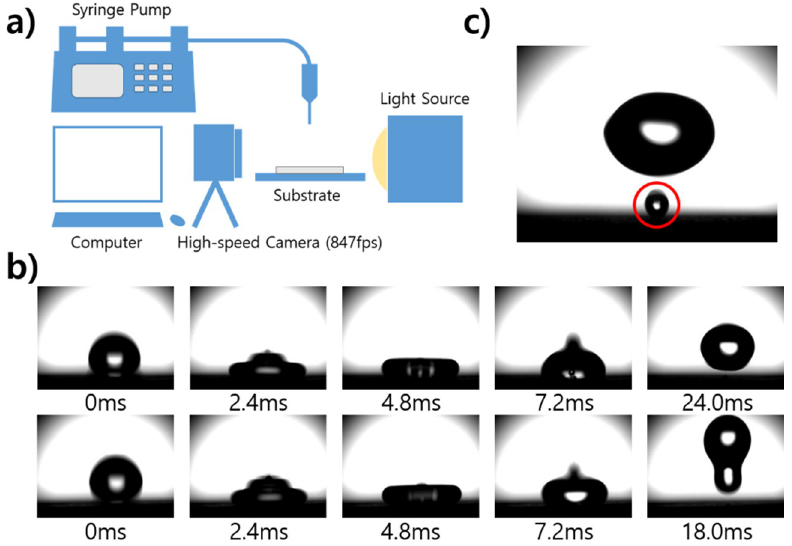
Fig 4. Observation and analysis of droplet collisions. (a) Composition of experimental equipment for droplet collision observation. The needle dropped droplets at a height of 20 mm from the surface and the droplet size is 2.8 ± 0.2 mm. The velocity of the droplet was 1.02 m/s. (b) Results of high speed cameras from contact with droplets to removal from surfaces. Compared with the specimen treated with the PE method, water droplets splashed faster on the specimen treated with RIE. (c) When water droplets bounced from the specimen treated with the PE method, small water droplets are scattered. The small droplets were between 0.4 and 0.5 mm in size.